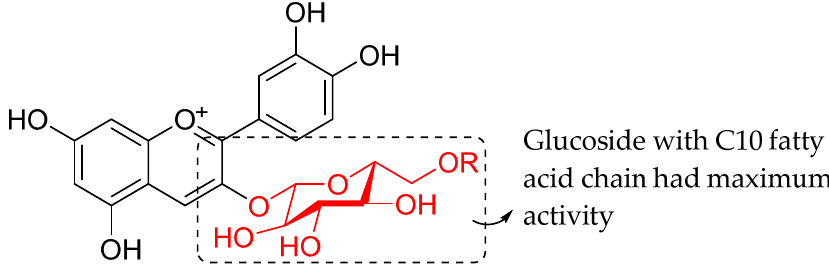
Figure 31. Key structural feature of cyanidin as antibacterial agent [101]. Shoaib et al. (2020) synthesized three halogenated flavone derivatives and tested their antibacterial activity against B. subtitlis , S. aureus , and P. aeruginosa . According to